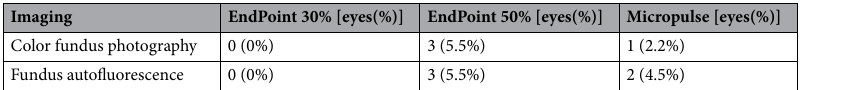
Table 4. Presence of post-treatment laser scar in eyes with diabetic macular edema in each treatment group as imaged by color fundus photography and fundus autofluorescence and graded anonymously.